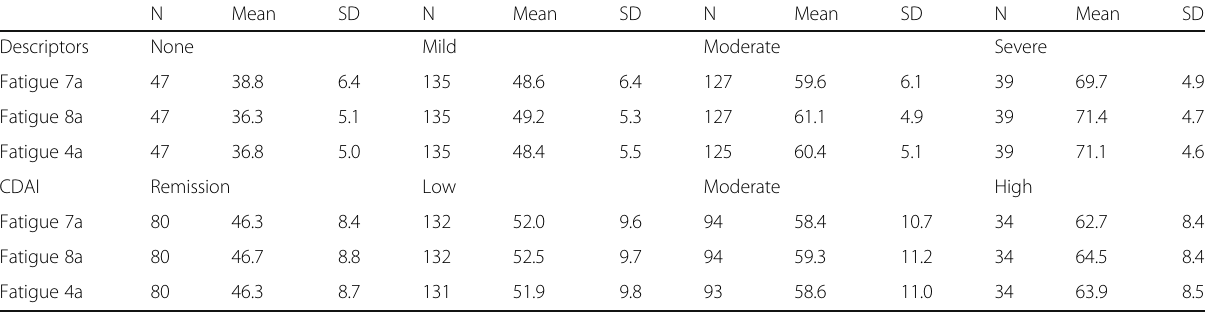
Table 5 Mean PROMIS fatigue scores by patient descriptors of symptom severity and indicators of RA disease activity